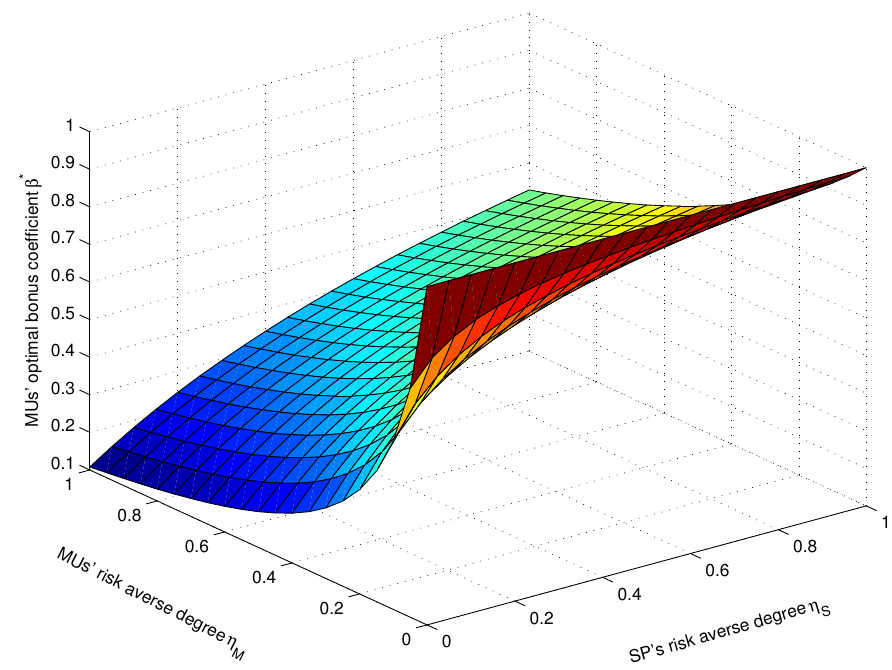
Figure 6. Mobile users’ (MUs’) optimal bonus coefficient β ∗ for fixed σ 2 = 1 and ¯ U =